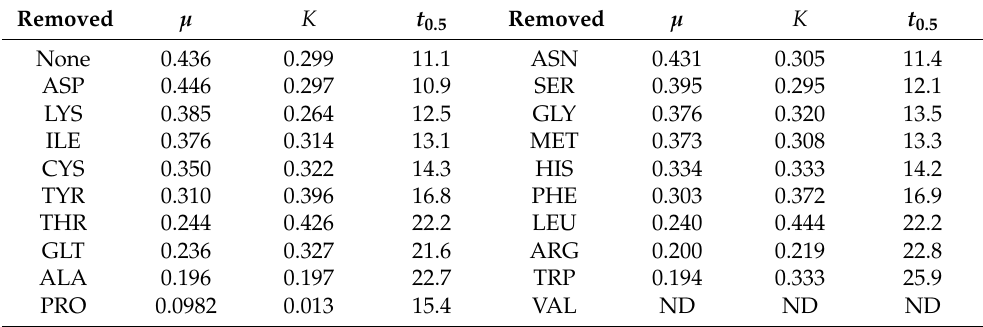
Table 3. Impact of removal of individual amino acids from the MHHW media on the growth characteristics of S. epidermidis : µ —specific growth rate, K —maximum biomass (gDW.L − 1 ), t 0.5 —time (h) to reach 0.5 K .